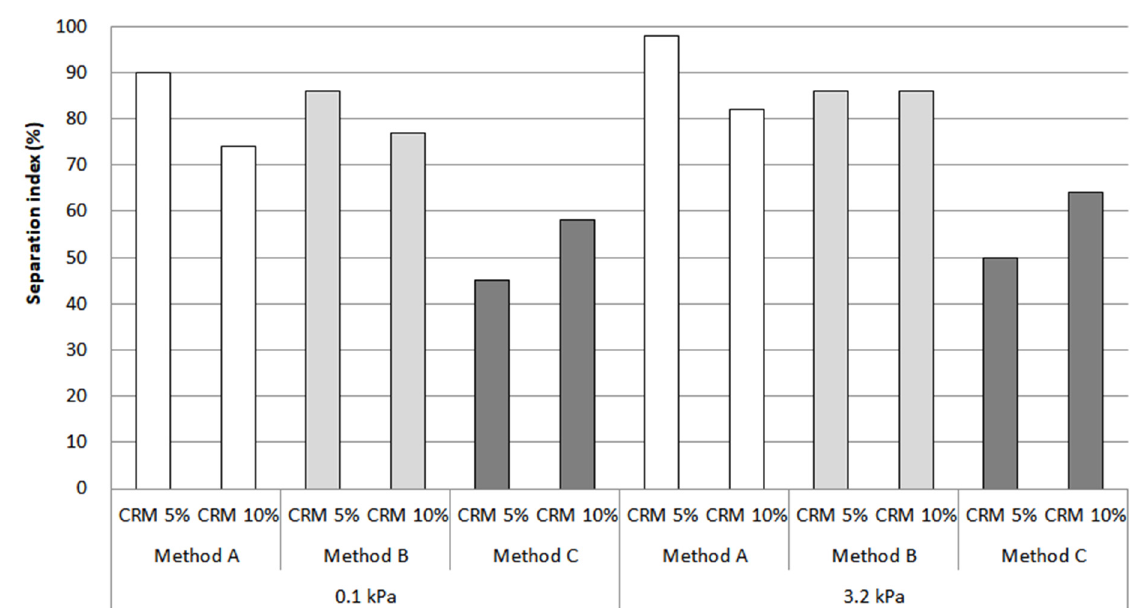
Figure 17. Separation index from percentage recovery.